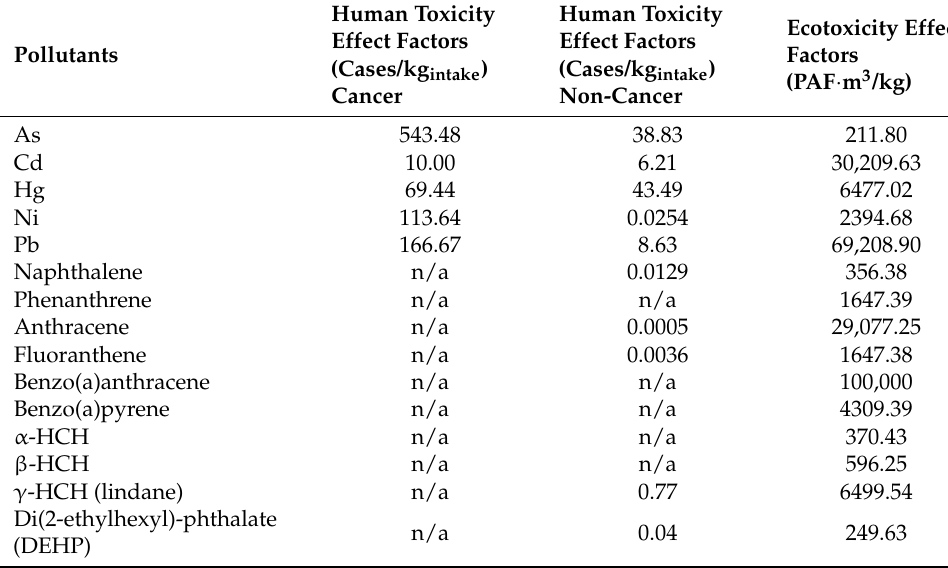
Table 4. The characterization factors for human toxicity and ecotoxicity